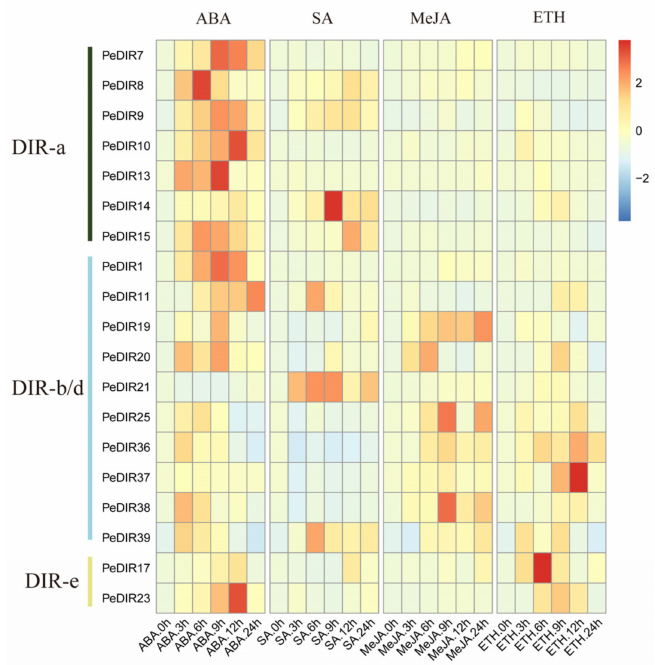
Figure 10. Hormone response pattern analysis of PeDIR genes by heatmap. PeDIR expression in the ‘Nanlin 895 (cid:48) response to exogenous hormone (ABA, SA; MeJA, and ETH) treatment for 0, 3, 6, 9, 12, and 24